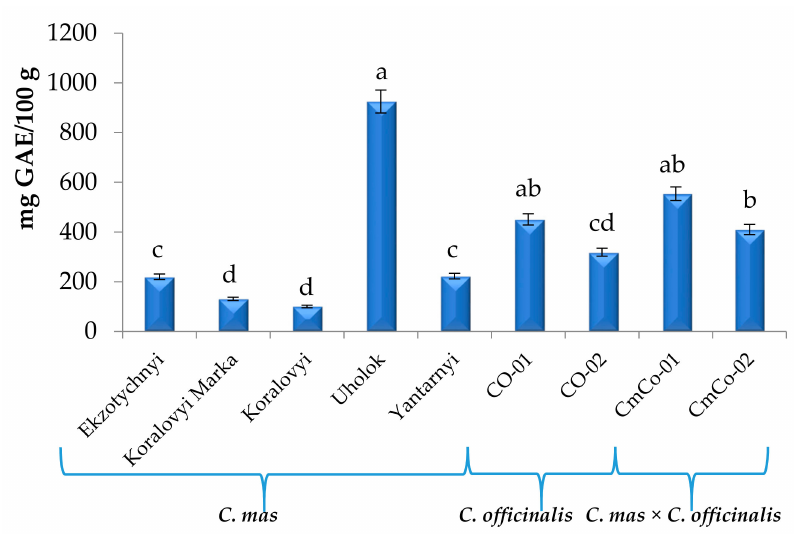
Figure 7. Total phenolic content (TPC) of C. mas L., C. officinalis Siebold & Zucc., and C. mas × C. offic- inalis fruit extracts, mg GAE/100 g (means in columns followed by different letters are statistically different at p ≤ 0.05). GAE, gallic acid equivalent.